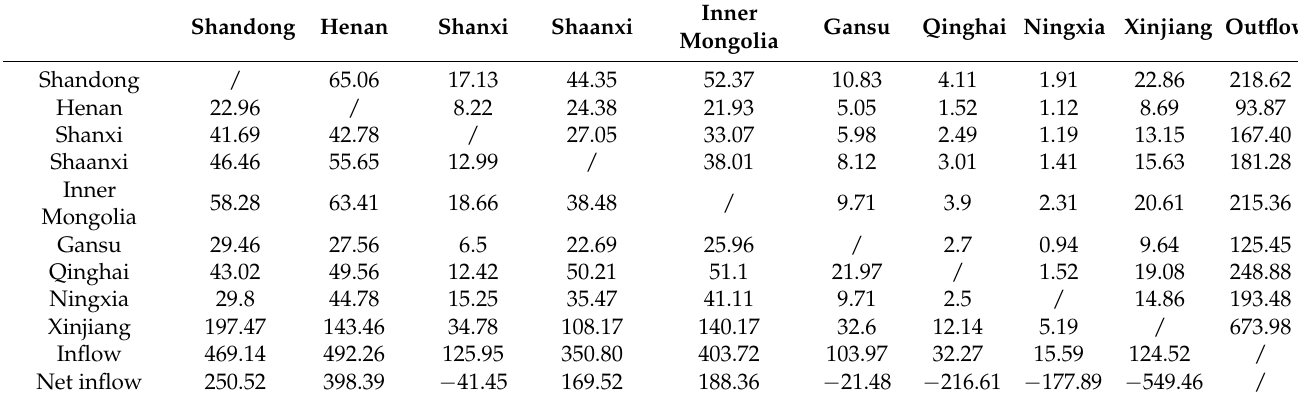
Table 3. Virtual water flow of each province in the Yellow River Economic Belt (100 million m 3 ). Shandong